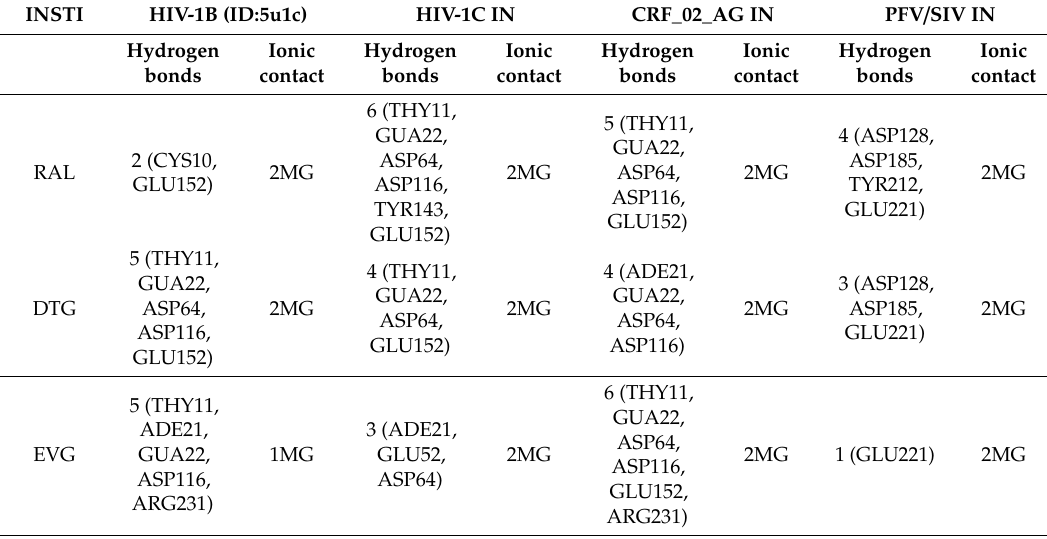
Table 2. Summary of all interactions observed between the five INSTIs and three IN subtypes. Listed also are interactions which occur between INSTI and PFV / SIV nucleic